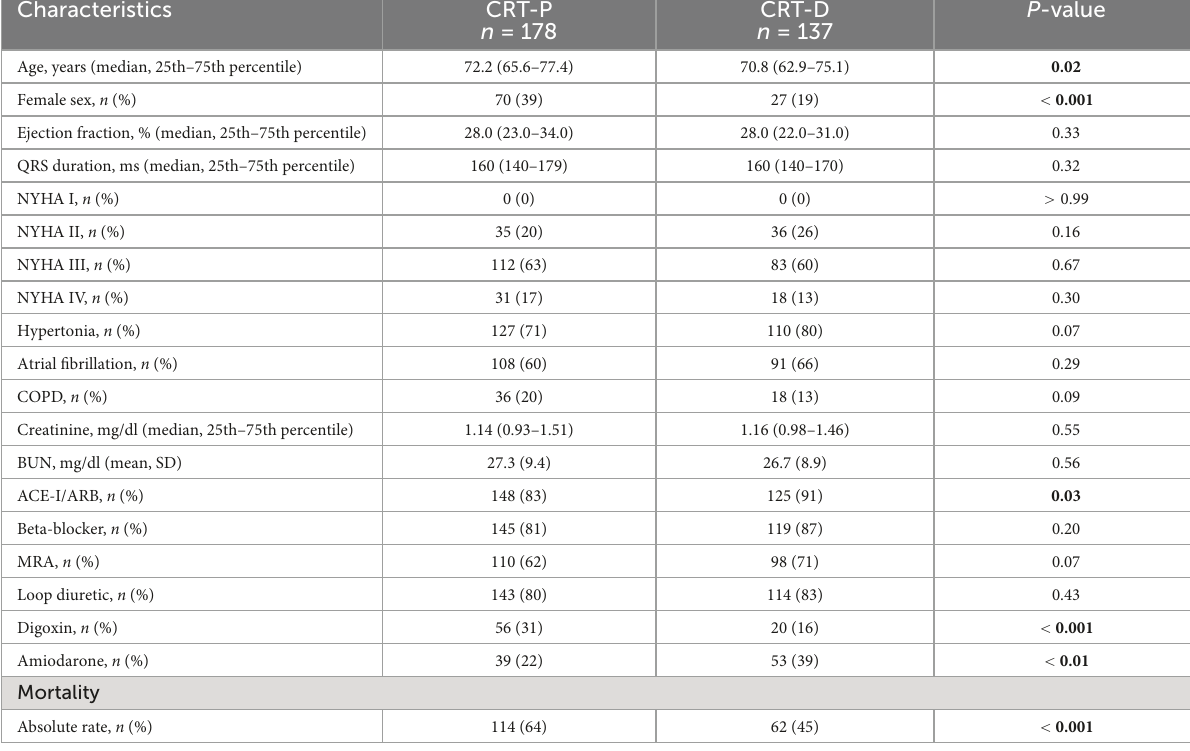
TABLE 3 Baseline characteristics of patients with Goldenberg risk score (GRS) ≥ 3.